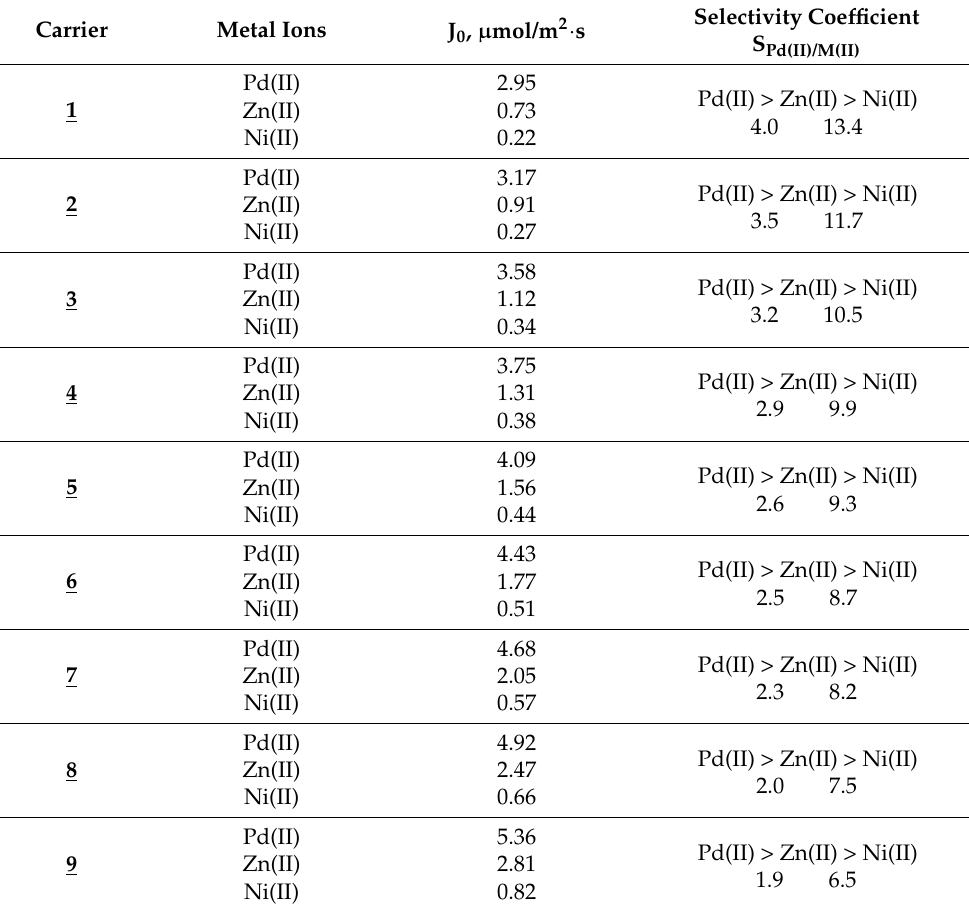
Table 8. The initial fluxes, selectivity order and selectivity coefficients for competitive transport of Pd(II), Zn(II), and Ni(II) ions across PIMs doped with 1-alkyl-1,2,4-triazole ( 1 – 9 ),